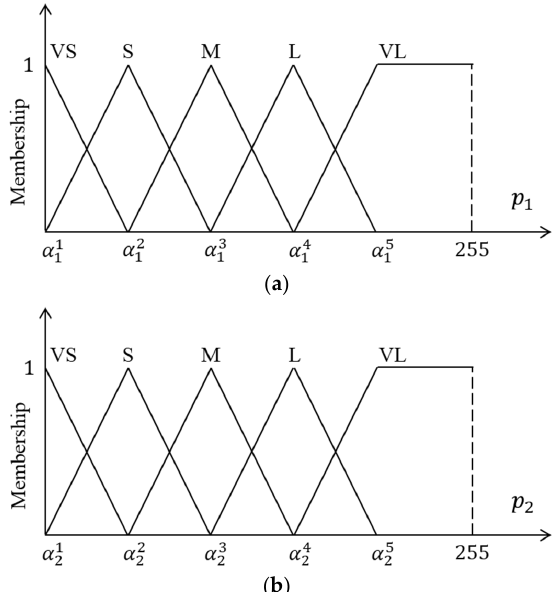
Appl. Sci. 2021 , 11 , x FOR PEER REVIEW Figure 10. Fuzzy sets of antecedent variables. Figure 10. Fuzzy sets of antecedent variables.